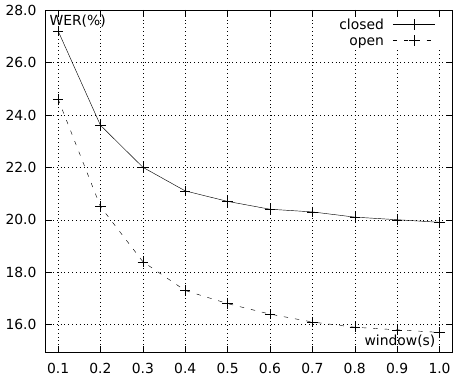
Figure 1. WER as a function of context window size (in seconds) for the streaming setup, computed over the dev1-dev set. This figure includes both the setup in this section (dashed line) and the setup for the closed-condition system described in Section 4 (solid